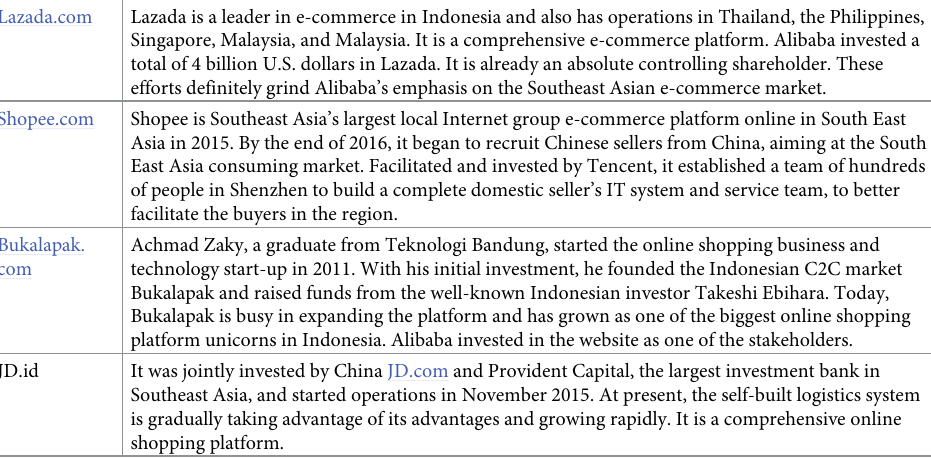
Table 1. The top four online shopping websites (investments from China) in Indonesia.